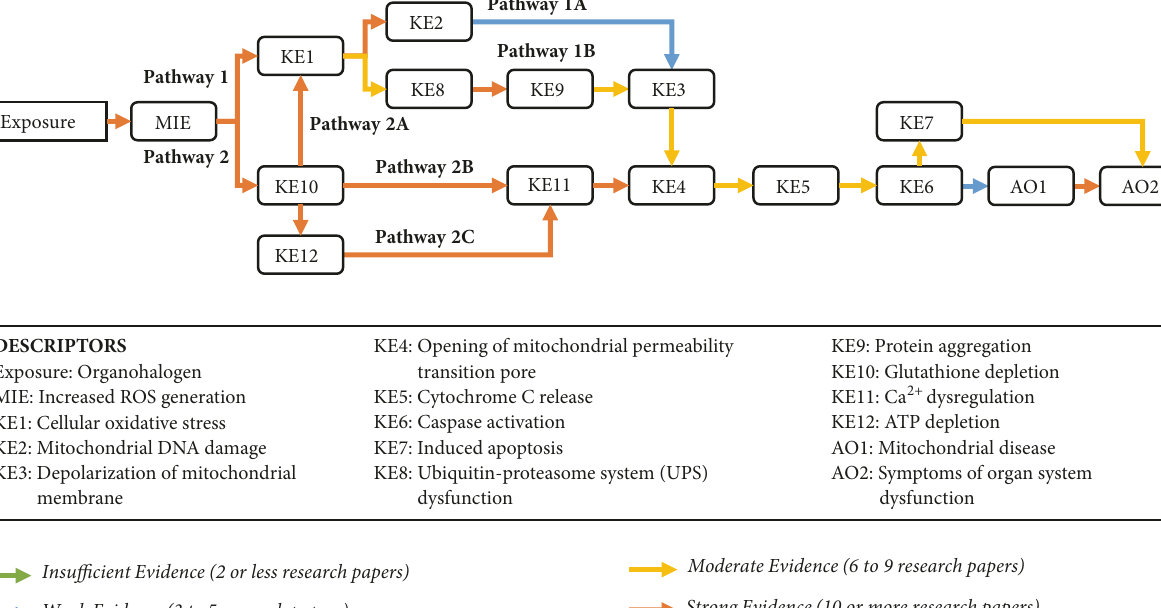
Figure 2: Weight of evidence assessment of key events (KE) and key event relationships supporting this AOP. All substances of interest (chloroform, chloroacetic acid, and chlorophenol) activate the proposed